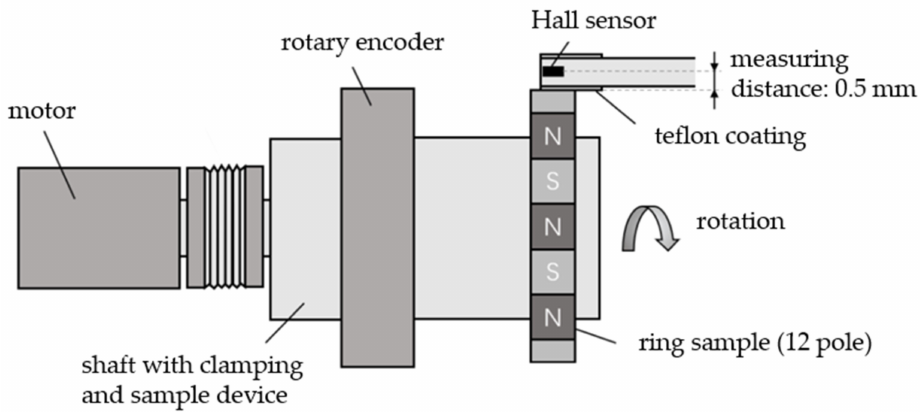
Figure 5. Schematic setup of the test rig for determining the magnetic flux density on the ring.